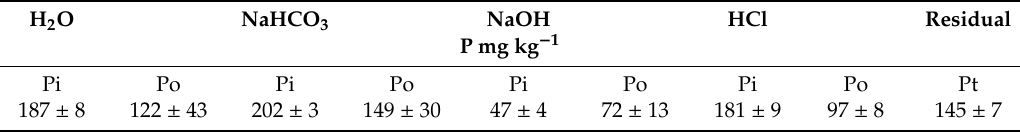
Table 2. Inorganic (Pi) and organic P (Po) in fractions sequentially extracted from poultry manure compost